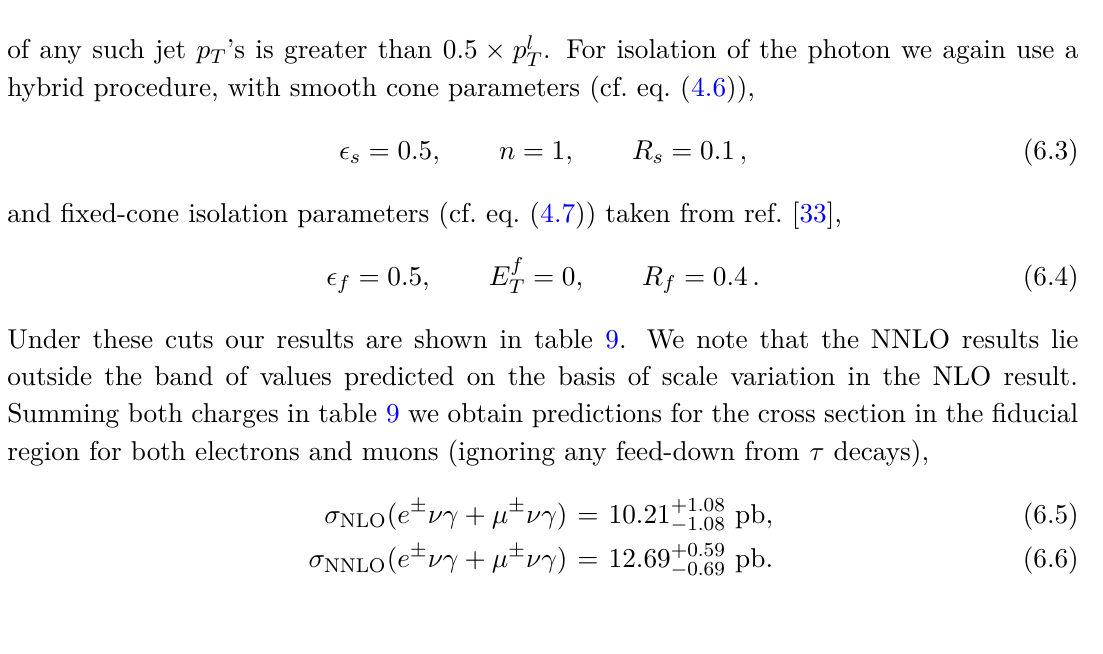
Figure 4 . Signed rapidity difference between the lepton and the photon, after the application of the cuts detailed in table 7 and the jet veto described in the text. The scale variation uncertainties are shown at NLO and NNLO. The lower panel shows the ratio of the NLO and NNLO results, including the uncertainty bands, to the central NLO